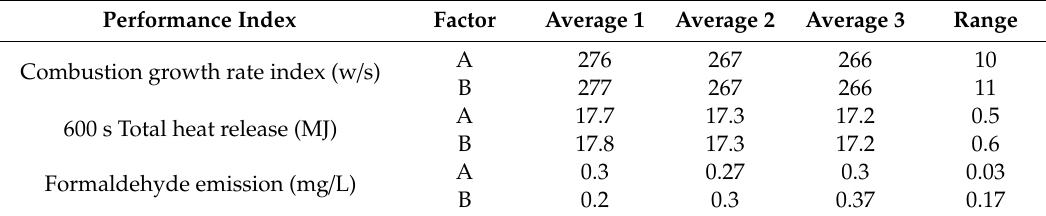
Table 5. Range analysis of one-time sizing optimization test.